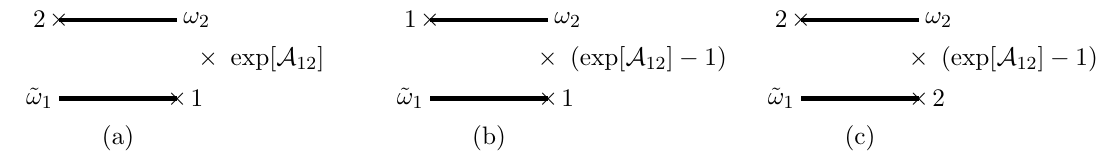
Figure 8 . The leading order two instanton contribution to the two point function of closed strings. As usual × denotes the disk one point function. A 12 denotes the full annulus contribution with the two boundaries lying on two different instantons. We also have a diagram in which 1 and 2 are exchanged in figure(a). The − 1 in the last two terms ensures that the underlying world-sheet has at least one boundary of each